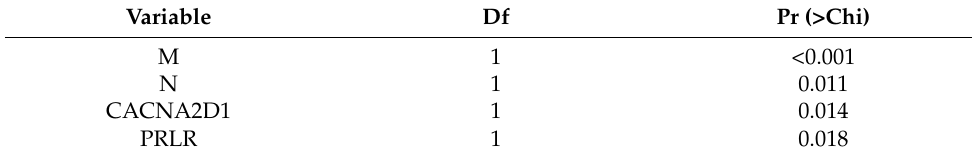
Table 3. Chi-square test of the